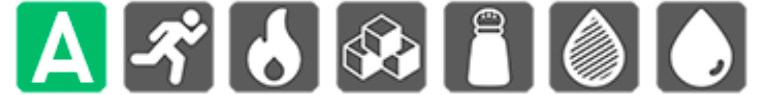
Figure A2. Seven icons representing the seven different nutrient labels, respectively. Note: The active icon affecting the DFLF functions is colored in green. The active button in Figure A2 represents the Nutri-Score label.